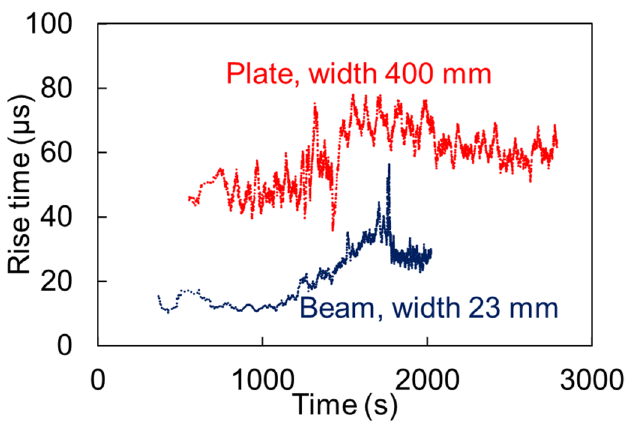
Figure 10. Sliding average of the rise time for plane TRC specimens with different widths under three-point loading.